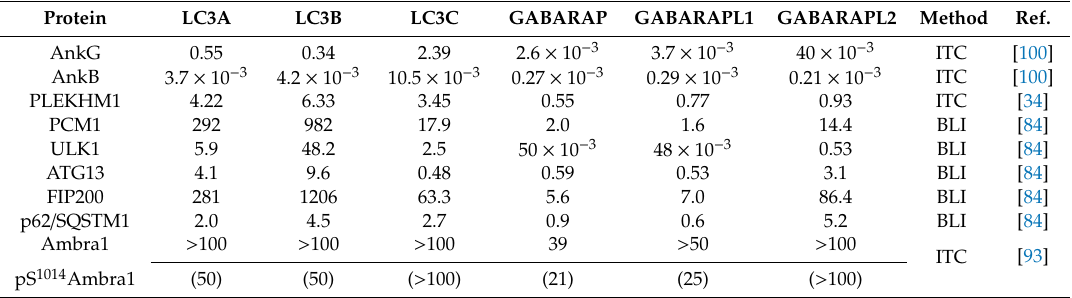
Table 1. K D values measured for interactions between di ff erent LIRs and LC3 / GABARAP proteins. All K D values are given in µ